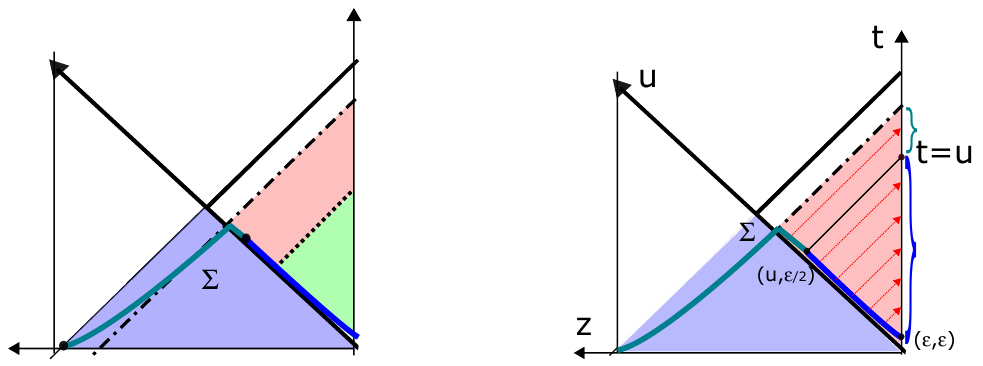
Figure 9 . Left: evaporating black hole structure, with a spacelike Cauchy surface (cid:6) superimposed. The surface is almost lightlike, and is divided in two pieces (blue and darkgreen). One computes the entanglement entropy between the two pieces, as the division point moves closer and closer to the (cid:12)nal event horizon as boundary time progresses. Right: early-late entanglement of Hawking quanta at the time t can be computed by computing the bulk entanglement entropy between both parts of the bulk Cauchy surface